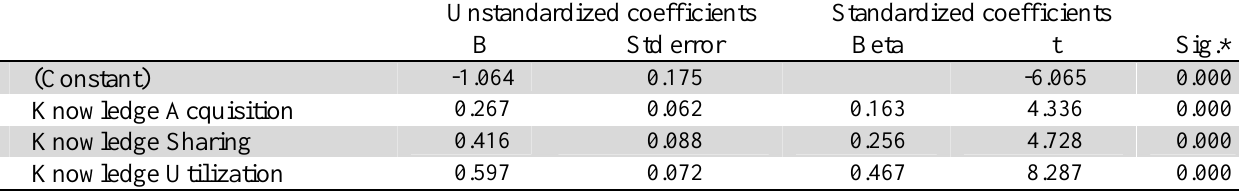
Regression equation- System Connections and knowledge management Unstandardized coefficients Standardized coefficients